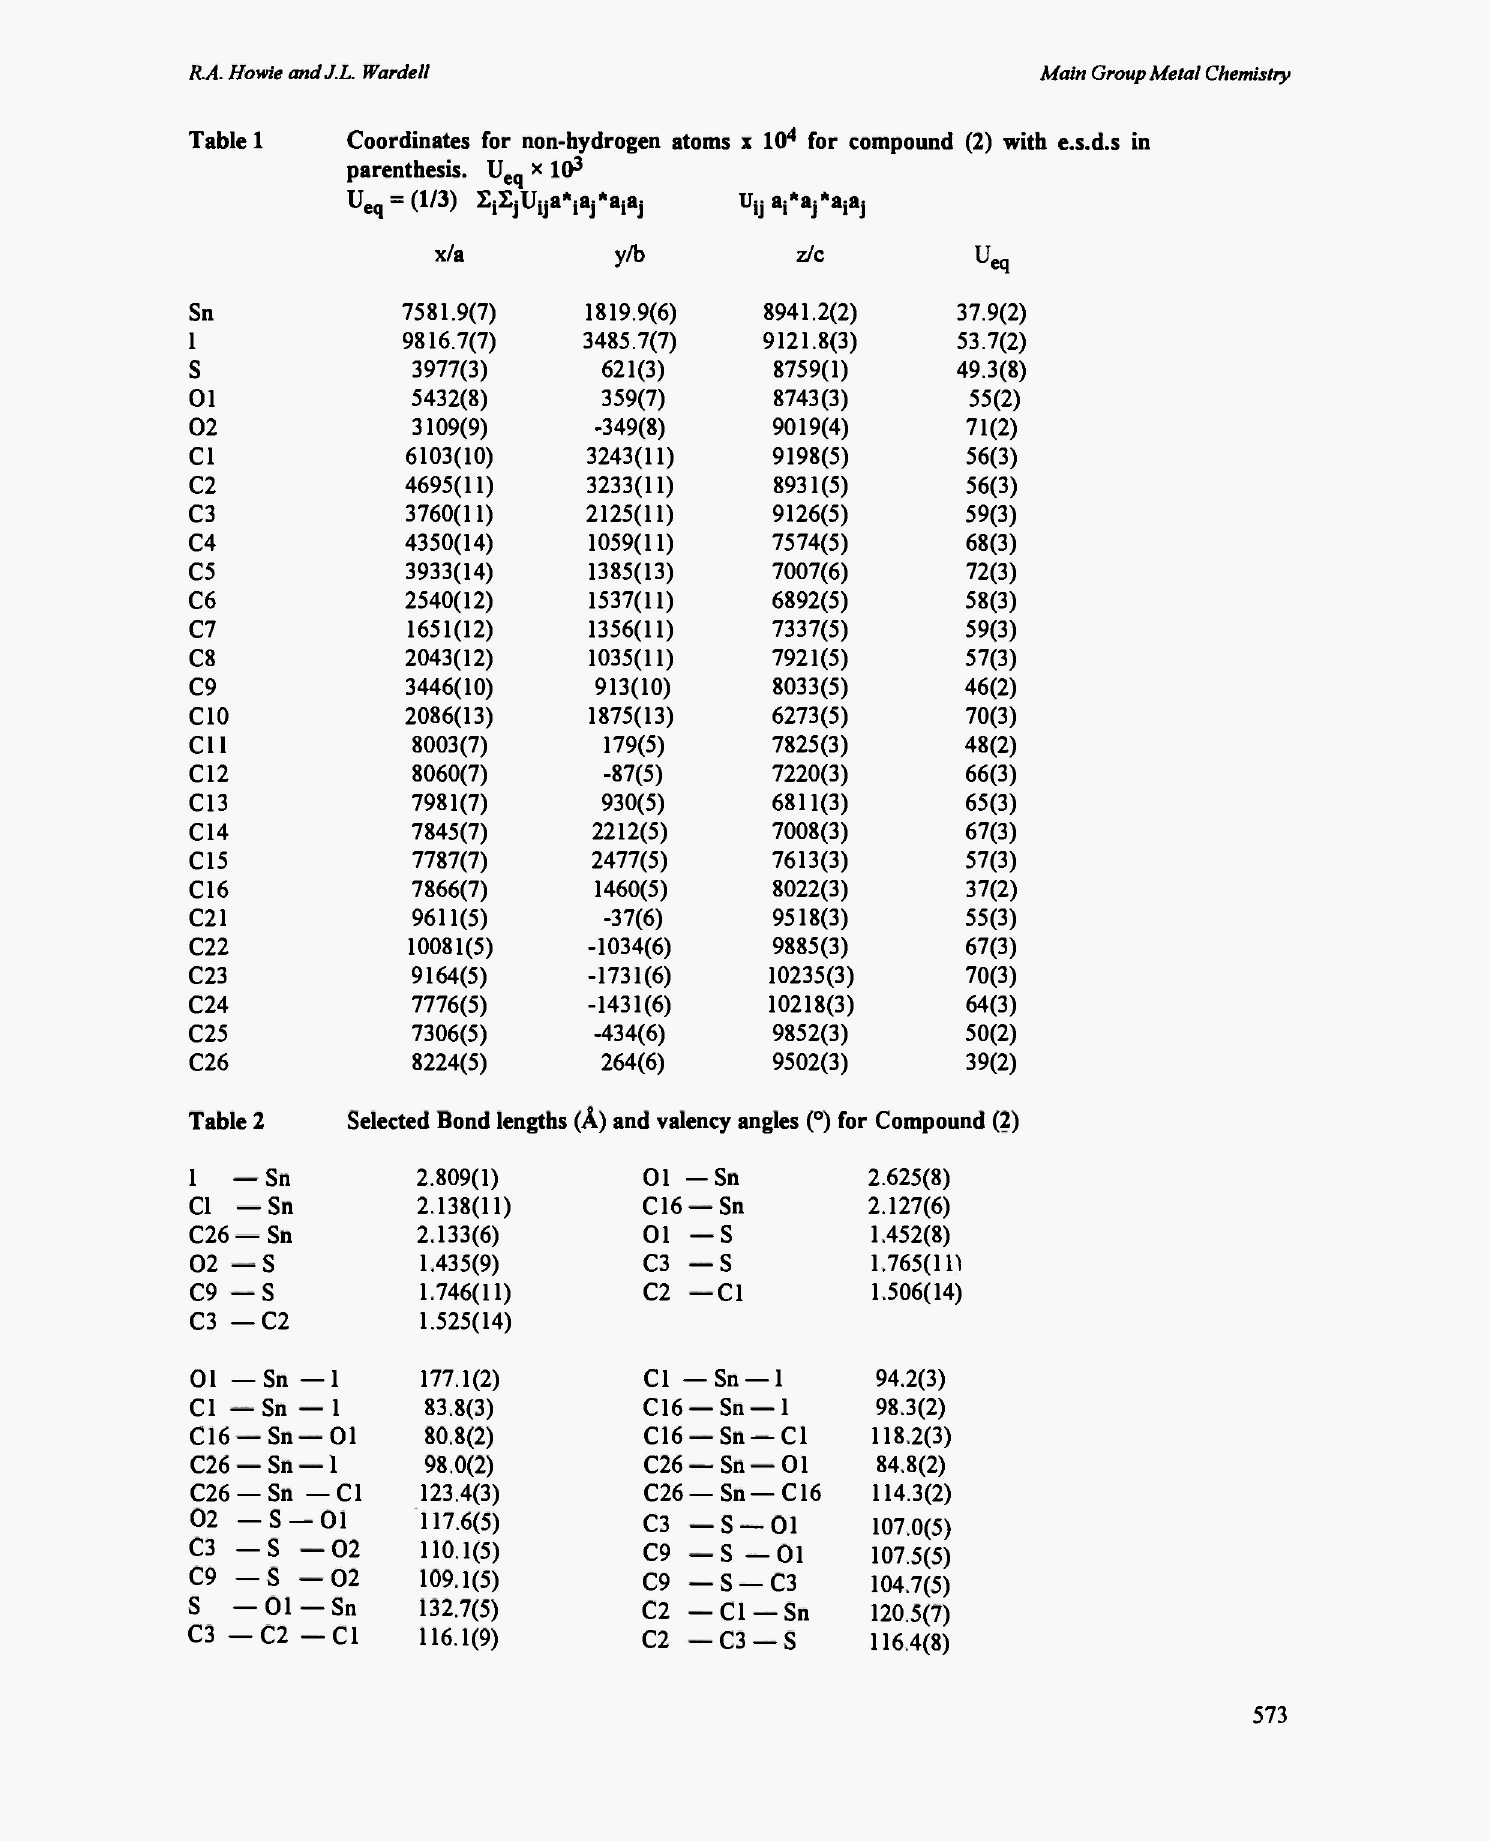
Selected Bond lengths (Ä) and valency angles (°) for Compound